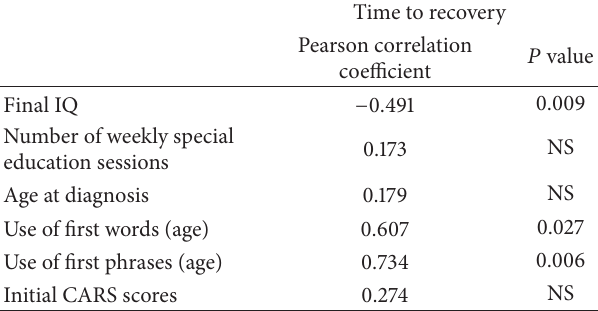
Table 4: Correlations of variables with length of time to optimal